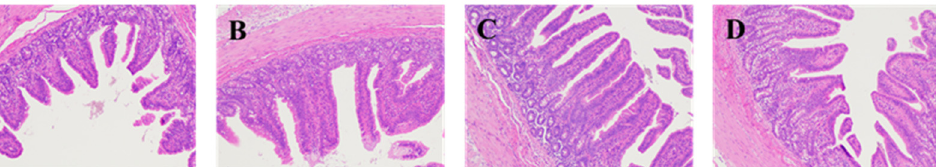
Figure 3. Effects of protease supplementation on ileum morphology of weaned piglets: ( A ) the control group; ( B ) adding 150 mg/kg protease; ( C ) adding 300 mg/kg protease; ( D ) adding 300 mg/kg protease.